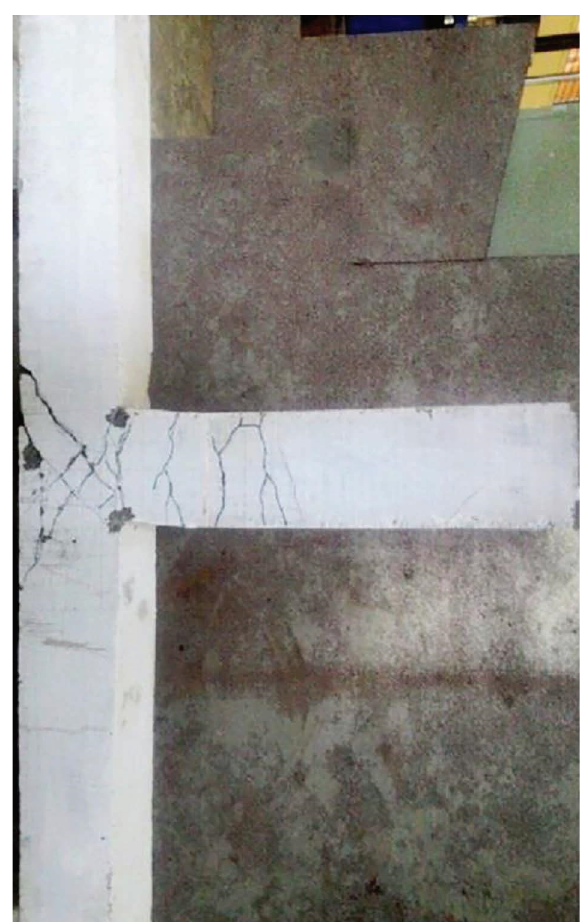
Figure 8: Fracture patterns of Alccofne 15%.